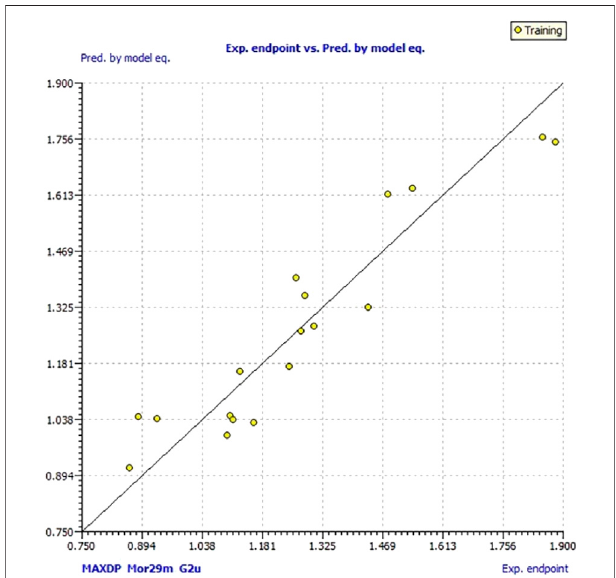
FIGURE 4 | Graph of experimental vs. calculated values of log LOX inh. % by the model (2).